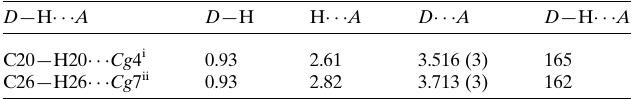
Table 1 Hydrogen-bond geometry (A˚ , (cid:3) ).